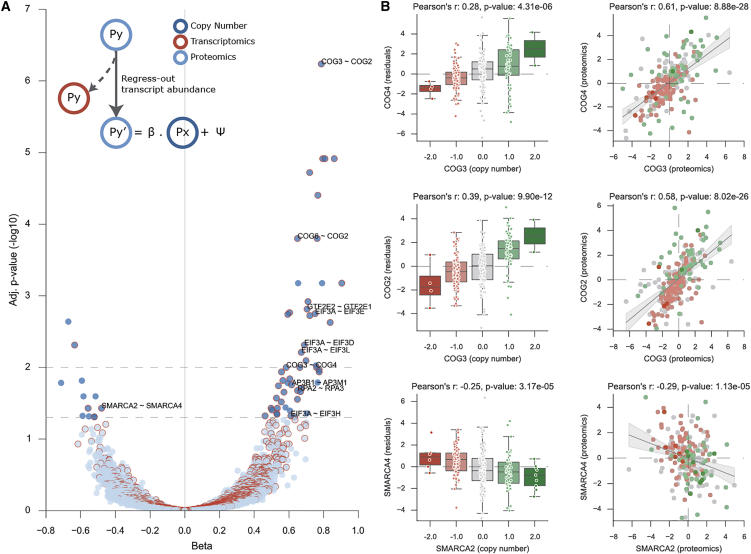
Protein Complex Regulators(A) Volcano plot displaying the effect size and adjusted p value of all the tested regulatory interactions. Associations were performed using the copy-number variation of the putative regulatory protein, Px, and the protein residuals of the regulated protein, Py. Significant associations found with the transcript measurements of Px are denoted with a red border.(B) Representative significant associations. Boxplots show the agreement between the copy-number variation of Px and the residuals of the regulated Py. Scatterplot show the agreement between the protein pairs in the proteomics measurements.